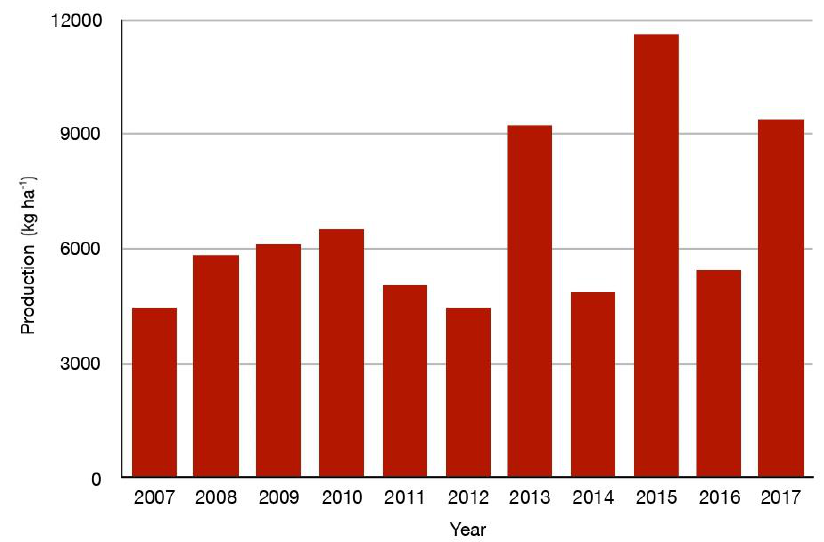
Figure 1. Yearly Green, Blue, Grey and total Water Footprint (m 3 t − 1 ) compared with olives yearly production (kg ha − 1 ).